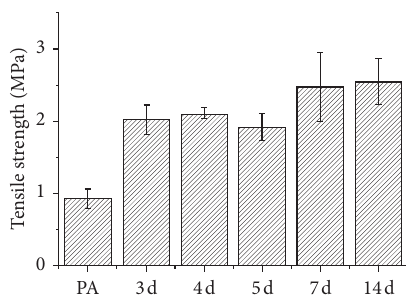
Figure 10: Tensile strength of PA and SFP specimen with different curing